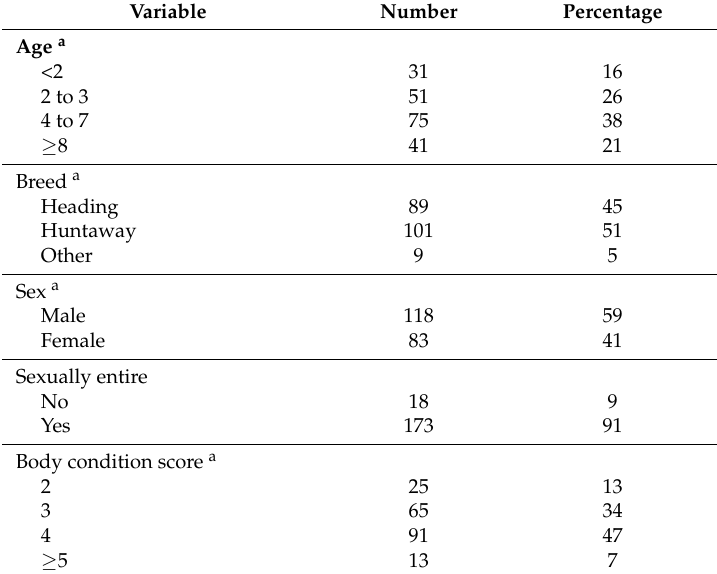
Table 1. Characteristics of working farm dogs ( n = 197 dogs). Data from a cross-sectional survey of working dogs’ health conducted in the central North Island of New Zealand in 2010 which included 57 working farm dog owners and 202 working